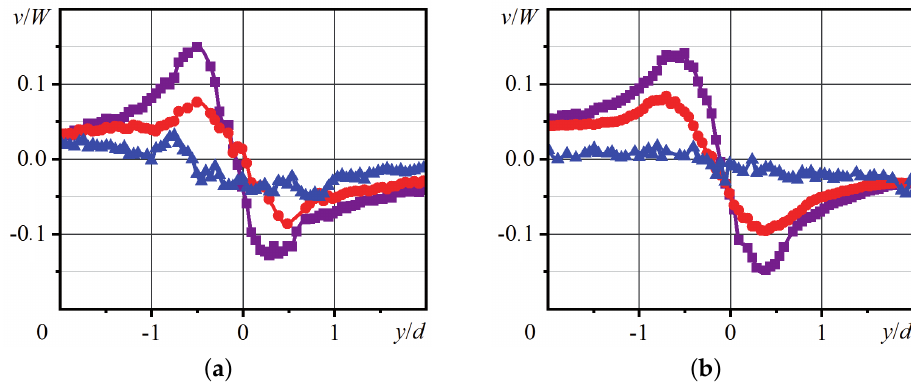
Figure 12. Profiles of the transverse velocity component v at: ( a ) Re = 4.8 × 10 3 and ( b ) Re = 20.2 × 10 3 ( S = 2 d : purple curve— x / d = 1.06; red curve— x / d = 1.54; blue curve— x / d = 2).